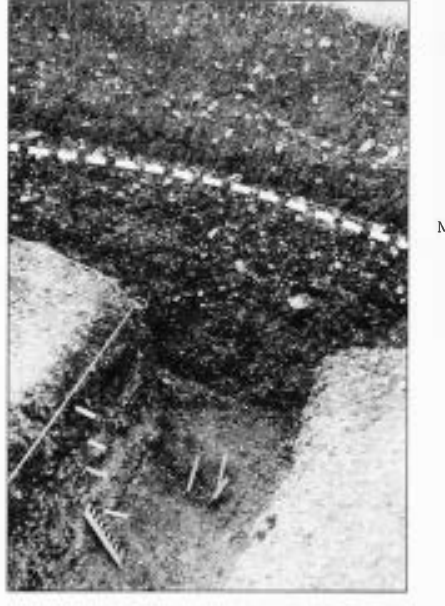
Figure 3 View of the stratigraphic se­ quence in the Culverwell mid den, show­ ing, below the dashed white line, the darker shell-rich mid den deposits beneath the overlying lighter colluvial deposits (scale bar